Question: Author a descriptive caption for the visualization shown.
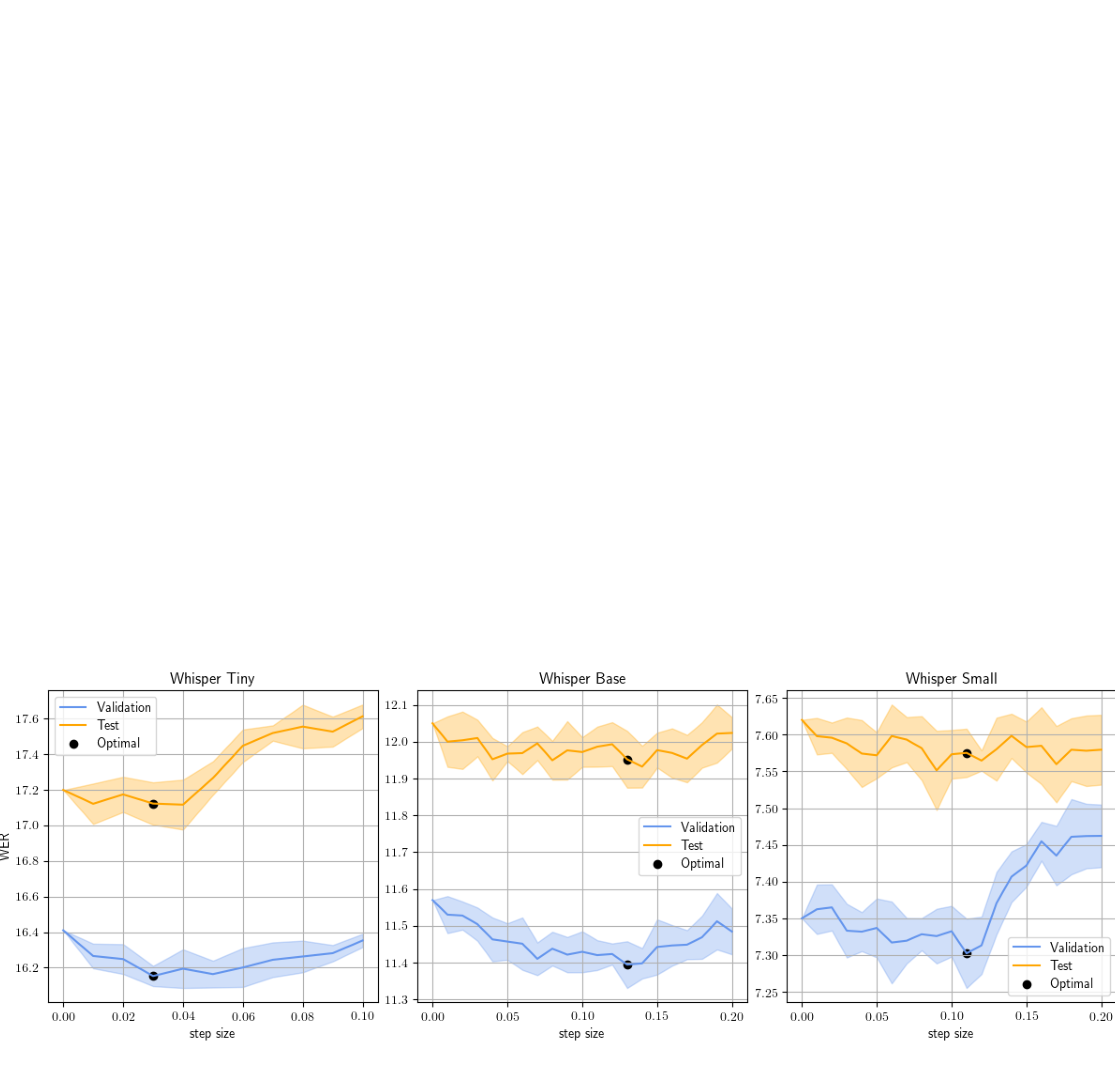
Answer: LibriSpeech other: Modifying encoder outputs using the gradient of a NAP. This shows how the performance changes when we vary the step size α of the modification. The optimal point was decided based on the minimum WER found on the validation set.